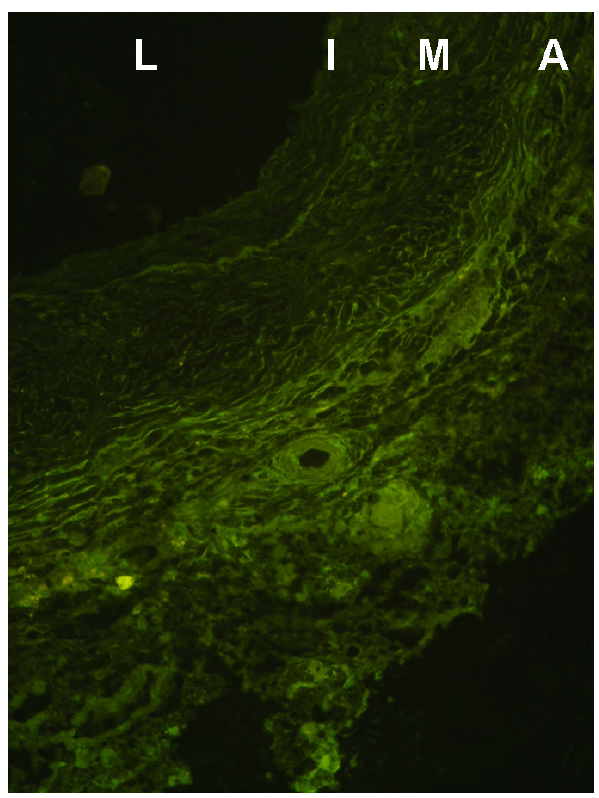
Figure 5. Histological features of arterialised immunosup- pressed alloveins. Representative light microscopic photograph showing the histological features of alloveins in immunosuppressed rats with tacrolimus (group B) 30 days following transplantation into the infrarenal abdominal aorta. Vein stained for immunoglobulins with a fluorescein isothiocyanate-conjugated antibody (Chemicon Internation- al Inc, Temecula, California, USA). No free clusters of immunoglobulins were detected in the thick arterialised wall of venous allograft.